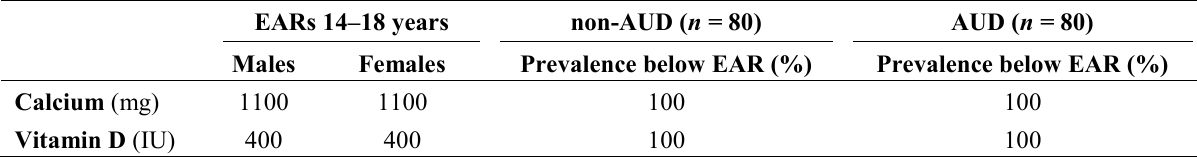
Table 4. Prevalence of risk of inadequate calcium and vitamin D intakes in the non-AUD and AUD groups using the EAR cut-point method, and comparisons between groups.